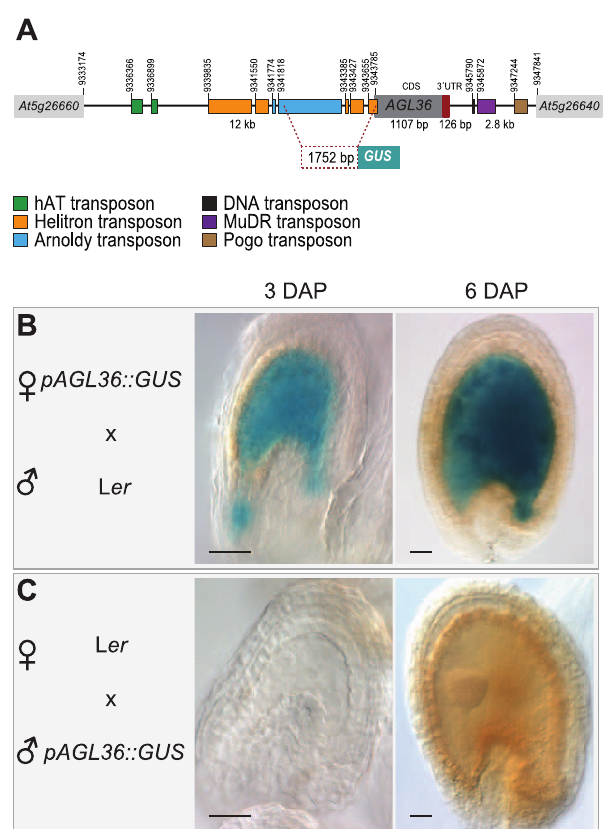
Figure 4. pAGL36::GUS is expressed only from its maternal allele (and only in the fertilization products). (A) A pAGL36::GUS construct was generated using 1752 bp of the promoter region of AGL36 that spans the ATG start codon. Transposable element sequences (hAT, Helitron, Arnoldy, DNA transposons, MuDR and Pogo transposons) in 5 9 and 3 9 regulatory regions are color coded as indicated. The numbers indicate the positions on Chromosome 5 (http://gbrowse. arabidopsis.org). Note, Helitron and Arnoldy transposable elements in the pAGL36::GUS promoter region. Plants expressing the transgene were used either as maternal (B) or paternal (C) partners in crosses with wild-type plants. Samples were taken at 3 DAP (left panel) and 6 DAP (right panel). pAGL36::GUS is absent in the seed-coat and only maternally expressed in the endosperm. The pAGL36::GUS signal is increased in 6 DAP versus 3 DAP